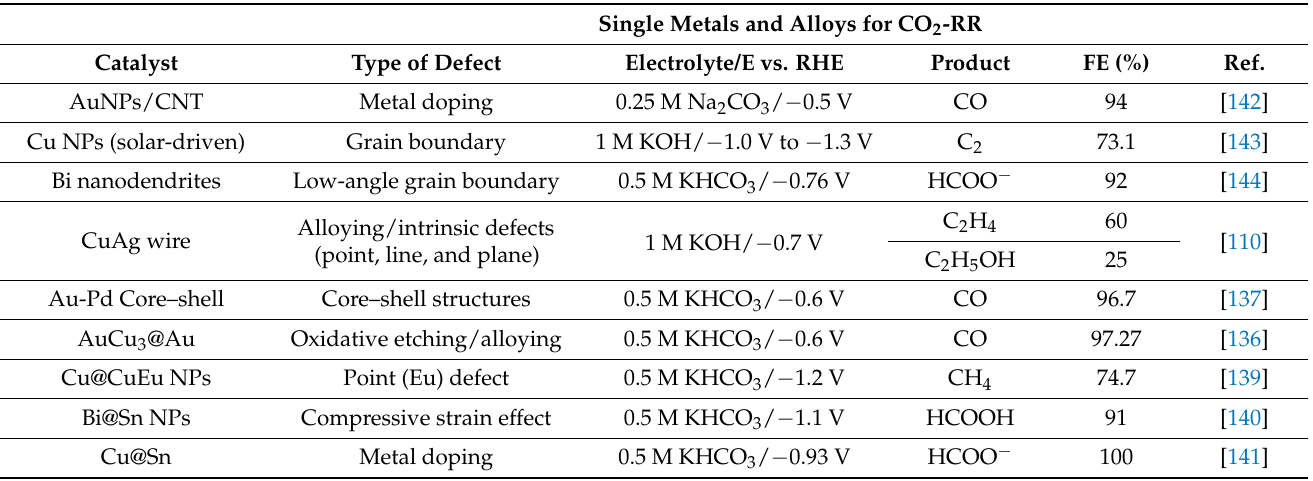
Table 2. Single-metal- and alloy-based electrocatalysts for electrochemical CO 2 -RR. Single Metals and Alloys for CO 2